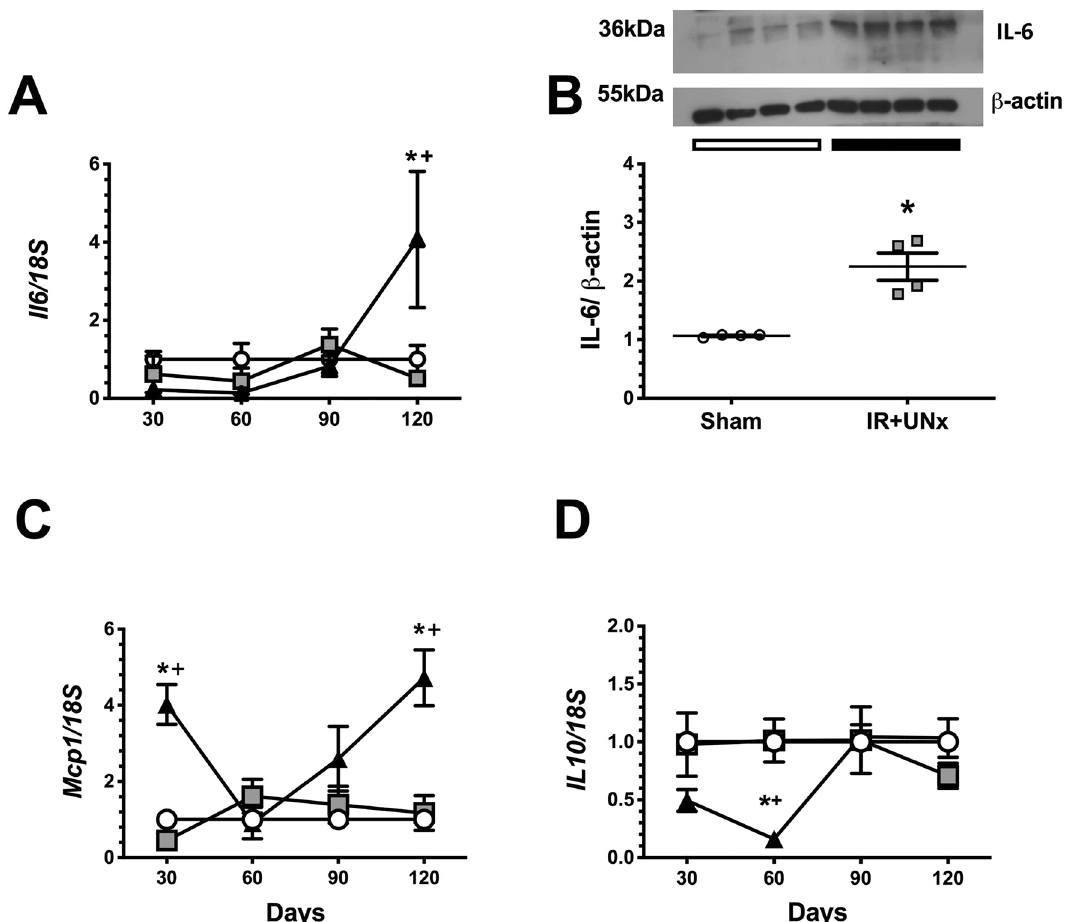
Figure 5. Inflammatory mediators participation during AKI to CKD transition. ( A ) mRNA levels of Il6 , ( B ) Protein levels of IL-6 at fourth-month post-ischemia, including a representative cropped blots, ( C ) mRNA levels of Mcp1 and ( D ) mRNA levels of Il10 . Data are represented as the mean ± SE. n = 4, 4, and 5 for the S, UNx, and IR + UNx groups in each studied period: 30, 60, 90, and 120 days post-ischemia. White circles/bar represent the S, gray squares represent the UNx and black triangles/bar represent the IR + UNx groups. The one-way analysis of variance (ANOVA) was used to determine statistical differences, using the Bonferroni correction for multiple comparisons. * p < 0.05 versus S group and + p < 0.05 versus UNx group in their respective period. Full-length blots are presented in Supplementary Fig.